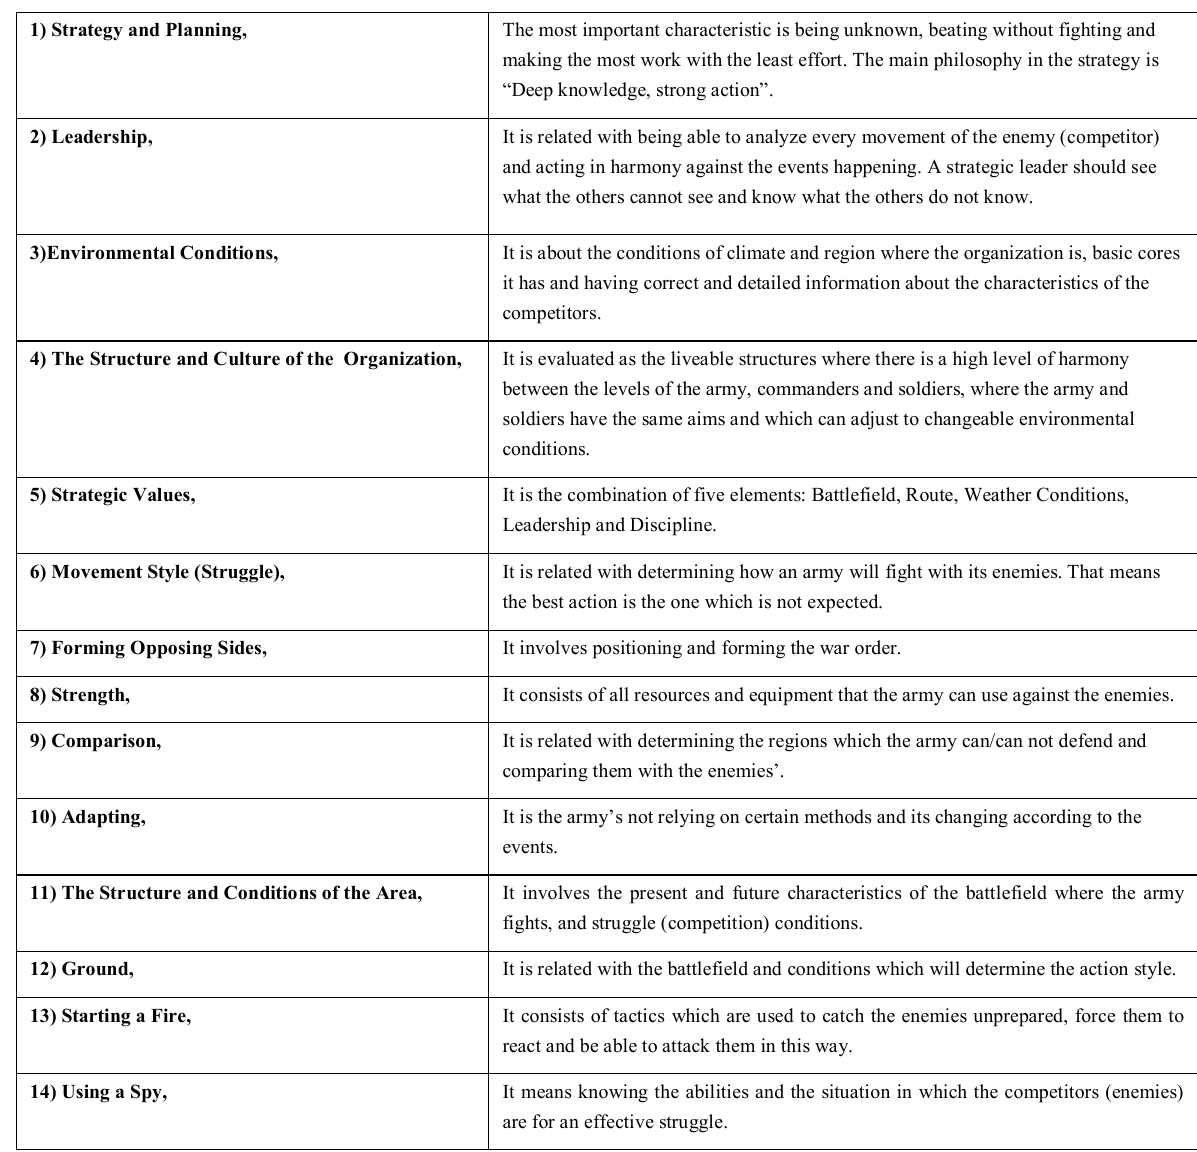
Table 4: Sun Tzu’s War Art Principles and Their